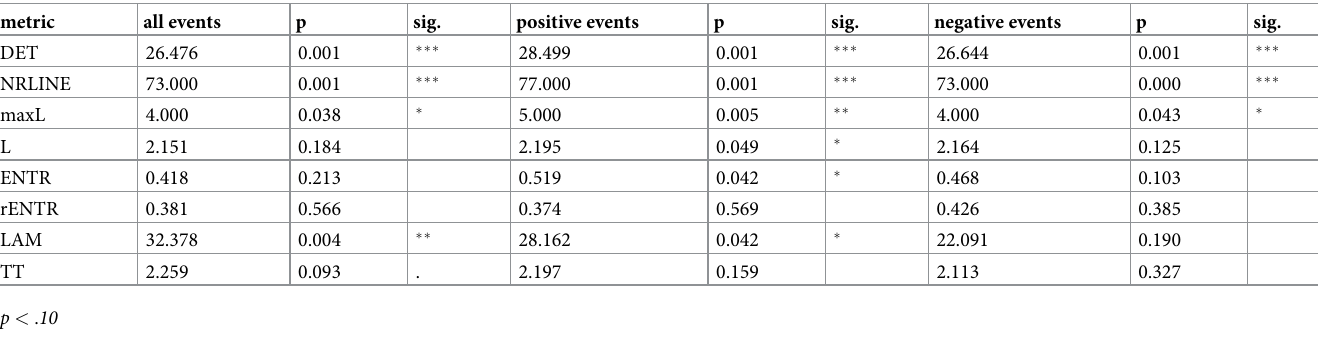
Table 6. CRQA results for retweets and source-target data. metric